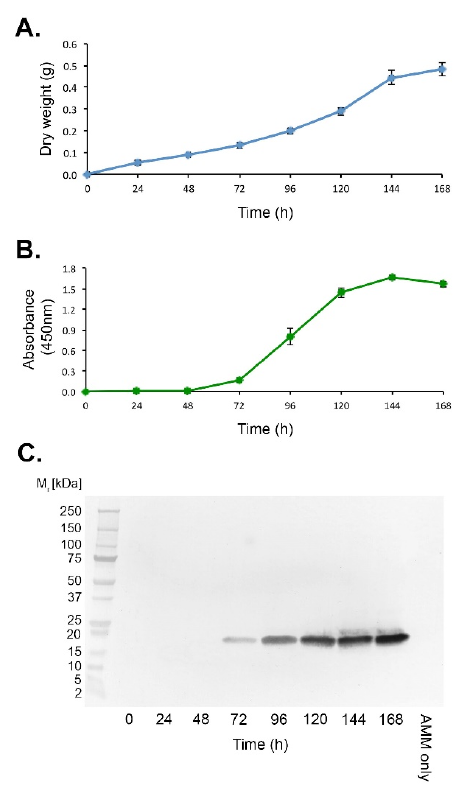
Figure 3. Production of the 18 kDa ribotoxin by the A. fumigatus sporulation-deficient mutant ∆ Af brlA in vitro . ( A ) Dry weights of the mutant over the 7 day experimental period. ( B ) Afu -ELISA ® of AMM protein precipitates using mAb PD7. Each data point in figures ( A , B ) is the mean of three replicates ±SE, and the threshold absorbance value for detection of protein in the Afu -ELISA ® ( B ) is ≥0.100. ( C ) Western blot of pooled protein samples, showing the appearance of the PD7-reactive 18 kDa protein at 72 h post-inoculation and at each time point thereafter. The negative control comprised AMM only.